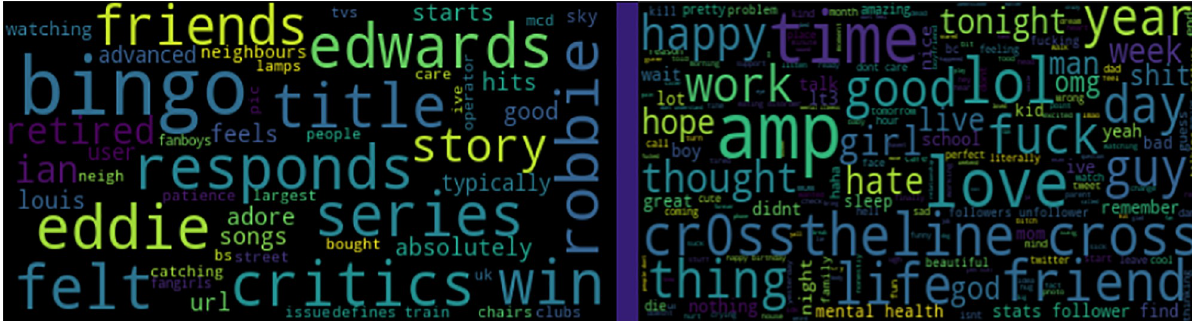
Fig 7. Word usage difference of likely vulnerable individuals versus random